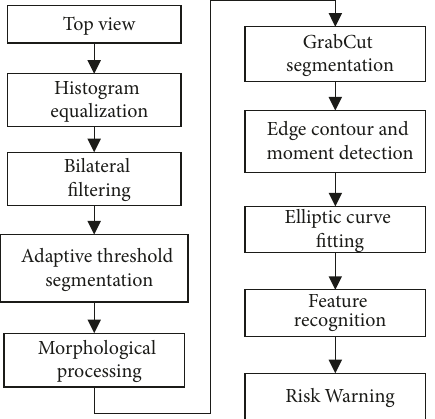
Figure 1: Algorithm frame diagram of the video monitoring system.